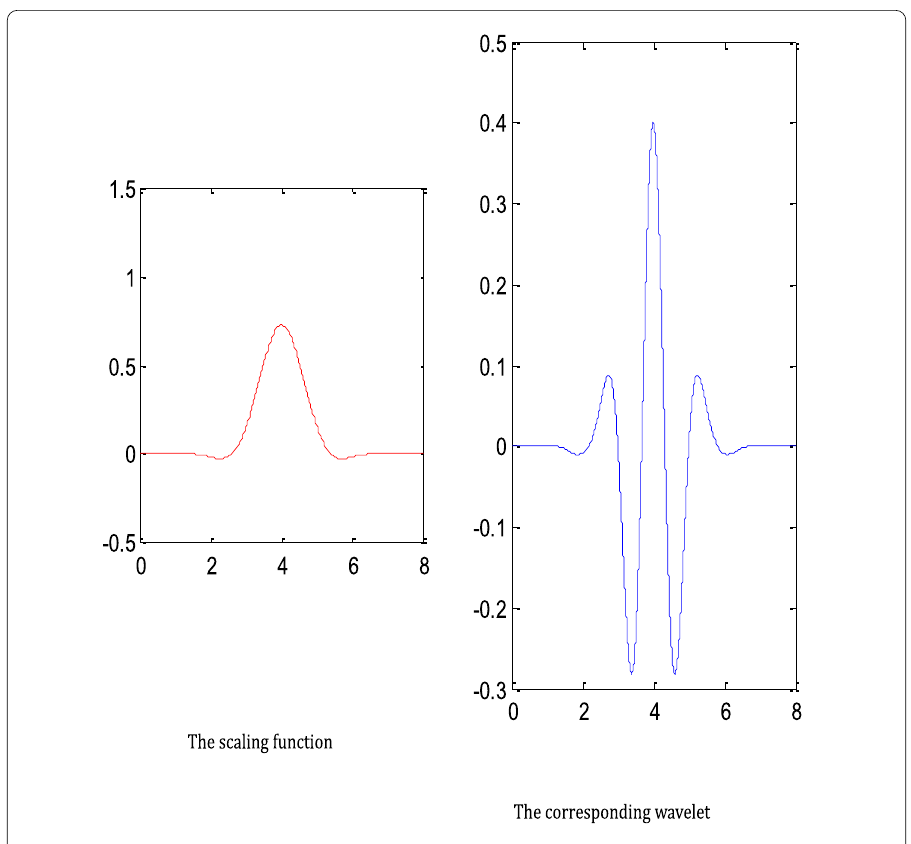
Figure 1 Graphs of the scaling function and the corresponding